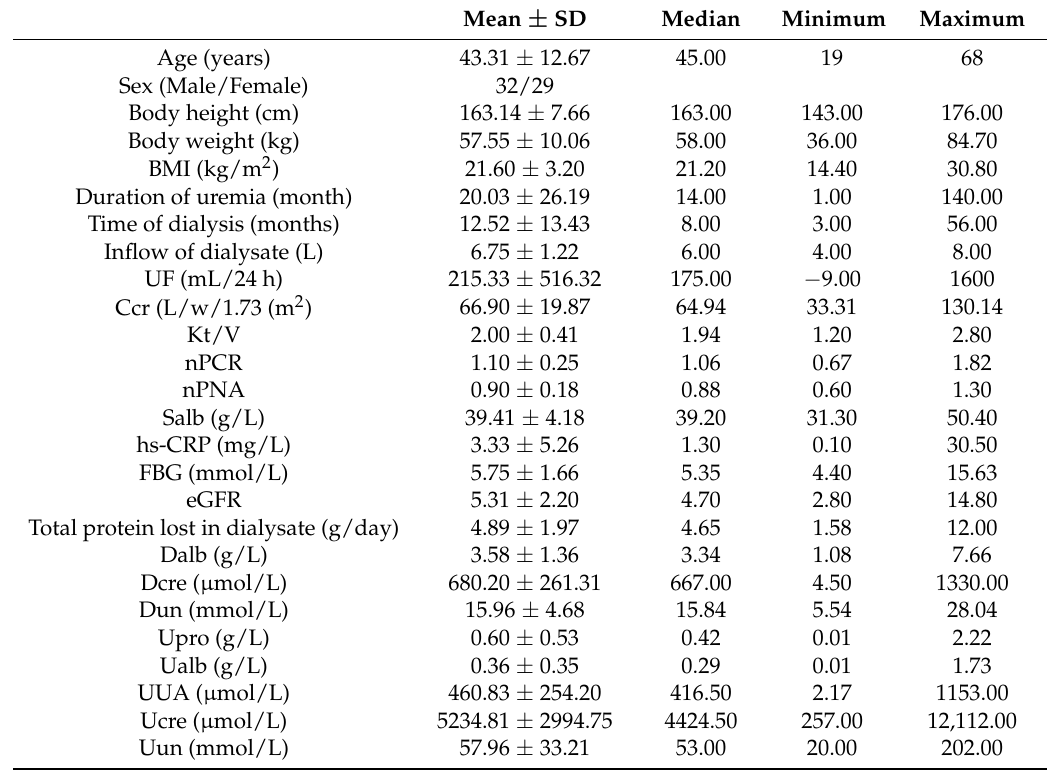
Table 1. The basic characteristics of CAPD